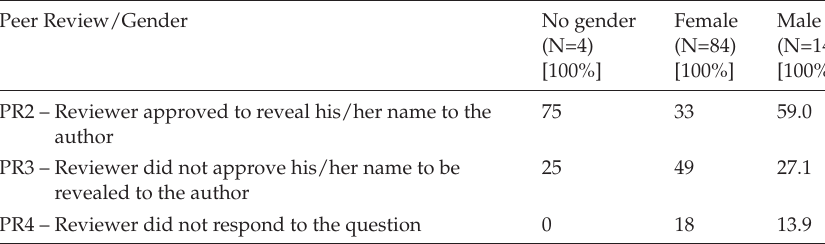
Table 11: Openness of reviewers’ identities and gender of the reviewers